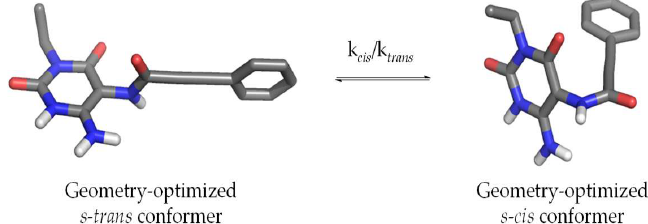
Figure 7. Geometry-optimized amide bond rotational conformers 8a and 8e . The conformers are shown in stick models (carbon atoms colored grey, oxygen atoms in red, the nitrogen atoms in blue, and the hydrogen atoms connected to nitrogen in white).